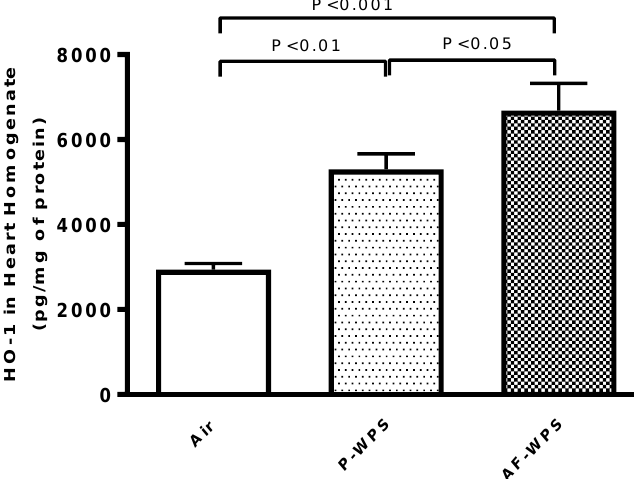
Figure 11. Effects of plain water-pipe smoke (P-WPS) or apple-flavoured (AF)-WPS on heme oxygenase-1 (HO-1) concentrations in heart. Heart homogenate concentrations of HO-1 at the end of 1 mo exposure period to either air or P-WPS or AF-WPS. Data are mean ± SEM (n = 5); one-way ANOVA followed by Holm–Sidak’s multiple comparison test.